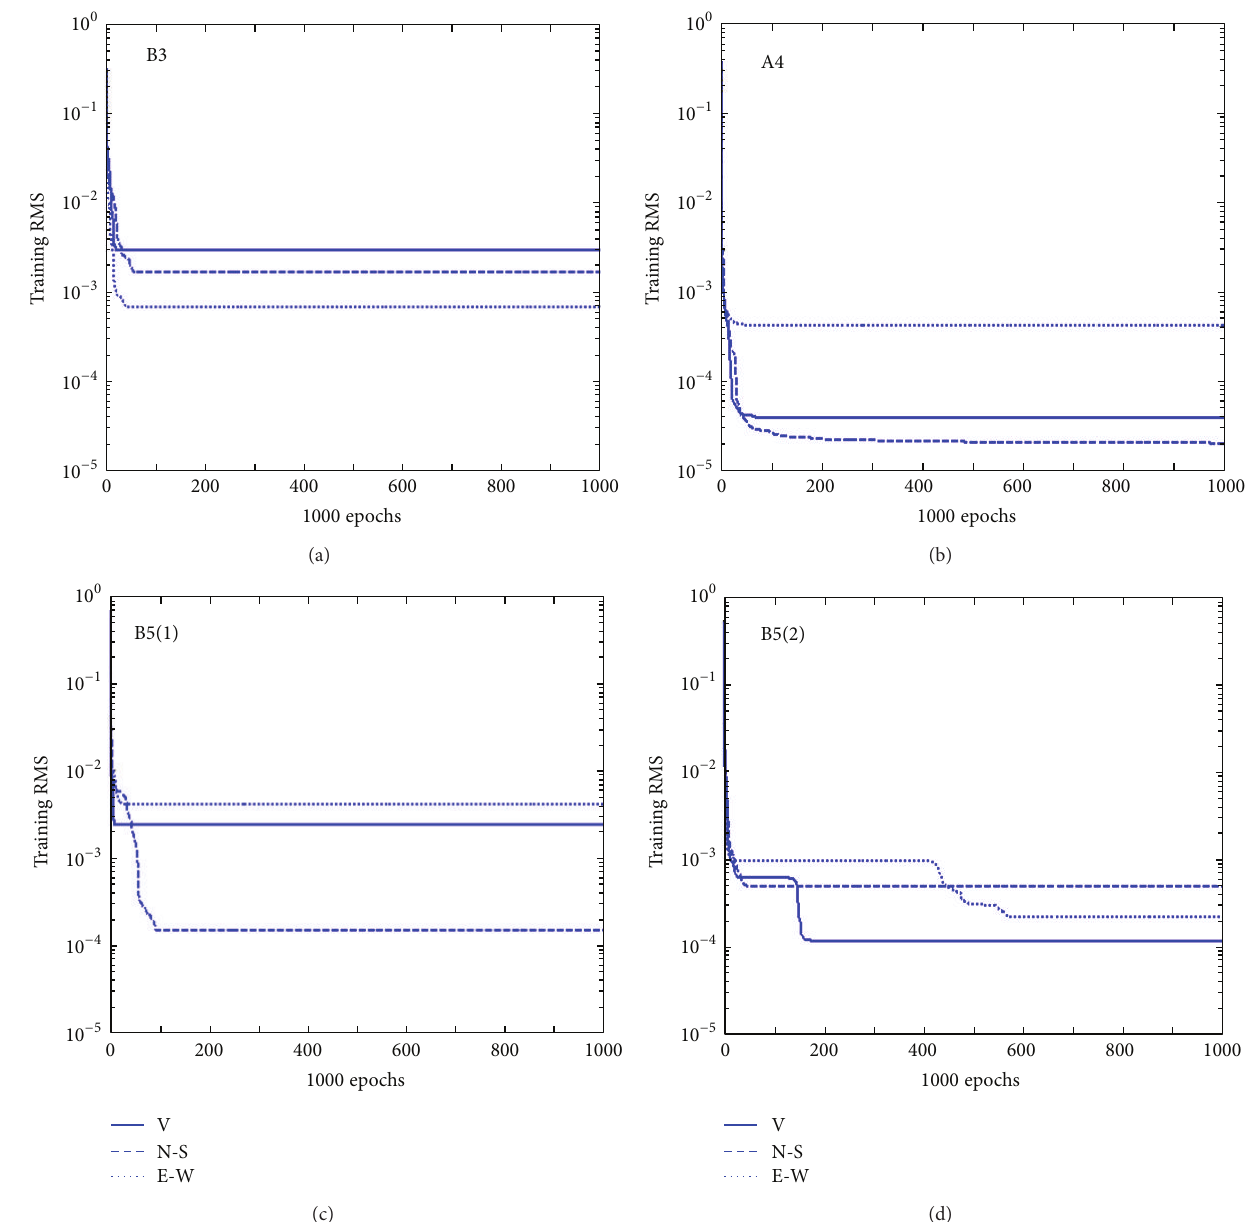
Figure 4: Examples of error convergent tendency in neural computing (RMSE versus